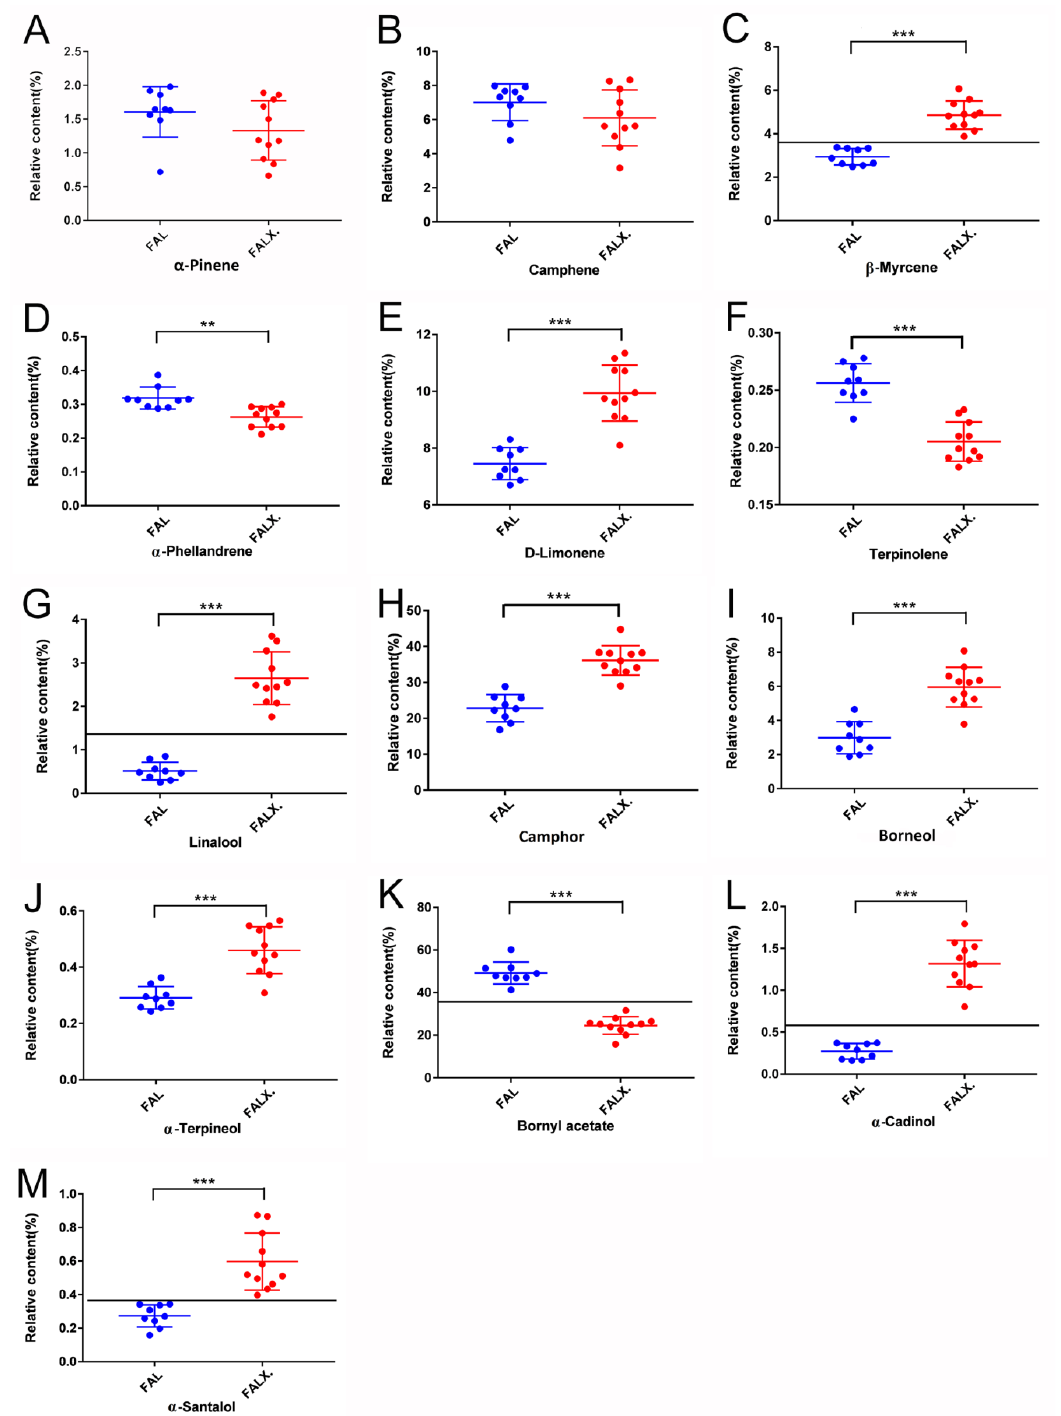
Figure 3. Relative contents of the common peaks in total ion chromatography (TIC) of FA from two species ( A ) α -pinene, ( B ) Camphene, ( C ) β -Myrcene, ( D ) α -Phellandrene, ( E ) d -Limonene, ( F ) Terpinolene, ( G ) Linalool, ( H ) Camphor, ( I ) Borneol, ( J ) α -Terpineol, ( K ) Bornyl acetate, ( L ) α -Cadinol and ( M ) α -Santalol. Data were presented as mean ± SEM. *** p < 0.001, ** p < 0.01compared with FALX. Blue dots meant the relative content of the common peaks in each FAL sample; while red dots meant those in each FALX sample.